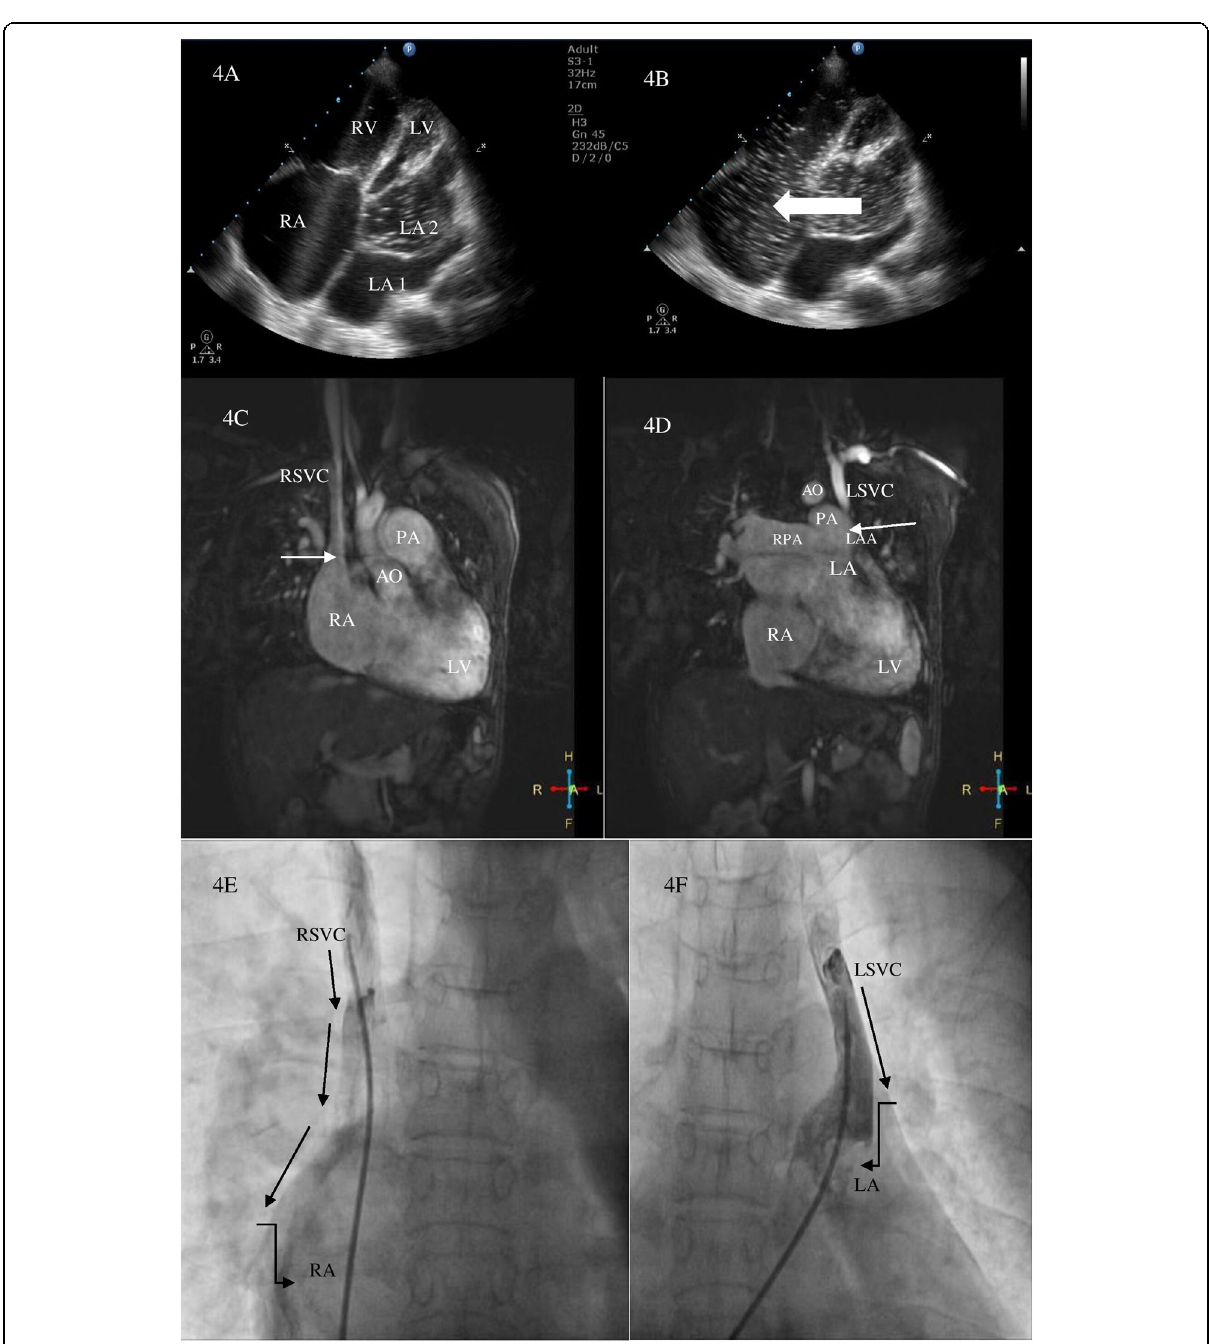
Fig. 4 Contrast transthoracic echocardiography in apical 4 chamber view with contrast injected in left antecubital vein showing contrast 1st appearing in LA2 ( A ) and then progressing to right atrium through the ASD (arrow) ( B ). Cardiac MRI showing right superior vena cava draining into right atrium (arrow) ( C ) and left superior vena cava draining into left atrium (arrow) with absence of innominate vein ( D ). Fluoroscopic image with Berman catheter in right superior vena cava showing right superior vena cava draining into right atrium (arrows) ( E ) and left superior vena cava draining into left atrium (arrows) ( F ) confirming completely unroofed coronary sinus. * Indicates completely unroofed coronary sinus. LA, left atrium; RV, right ventricle; LV, left ventricle; RSVC, right superior vena cava; LSVC, left superior vena cava; LAA, left atrial appendage; AO, aorta; PA, pulmonary artery; RPA, right pulmonary